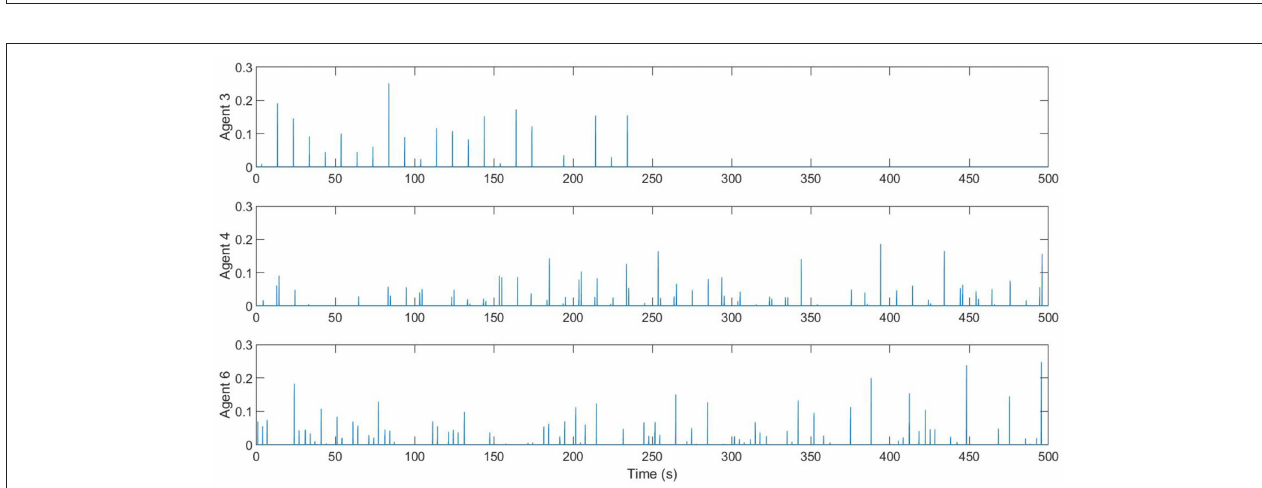
FIGURE 13 | The comparison between the rendezvous events in the beginning and near the end of the simulation. The bar indicating the rendezvous between agent 1 and 3 disappeared below the axis (after 400 s of simulation).